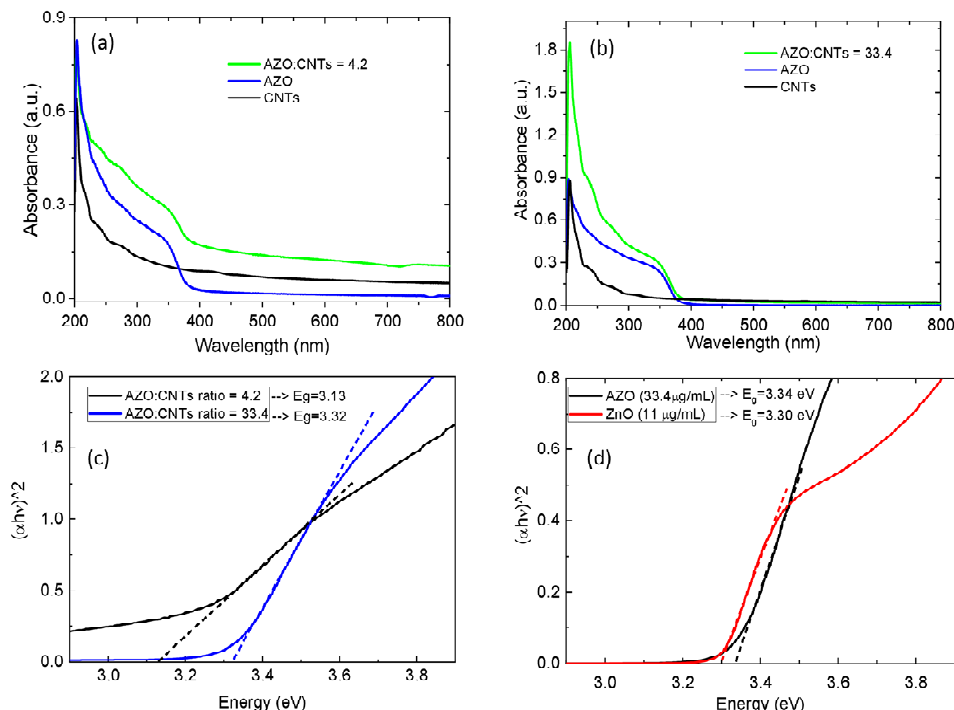
Figure 1. UV–Vis absorbance spectra of AZO–CNT solutions for ( a ) AZO:CNT weight ratio = 4.2 and ( b ) 33.4 spectra for AZO–NPs and CNTs solutions are added as comparison. In ( c , d ) Tauc plots for AZO–CNT composites and for AZO and ZnO nanoparticles, respectively, obtained considering a direct allowed transition ( n =